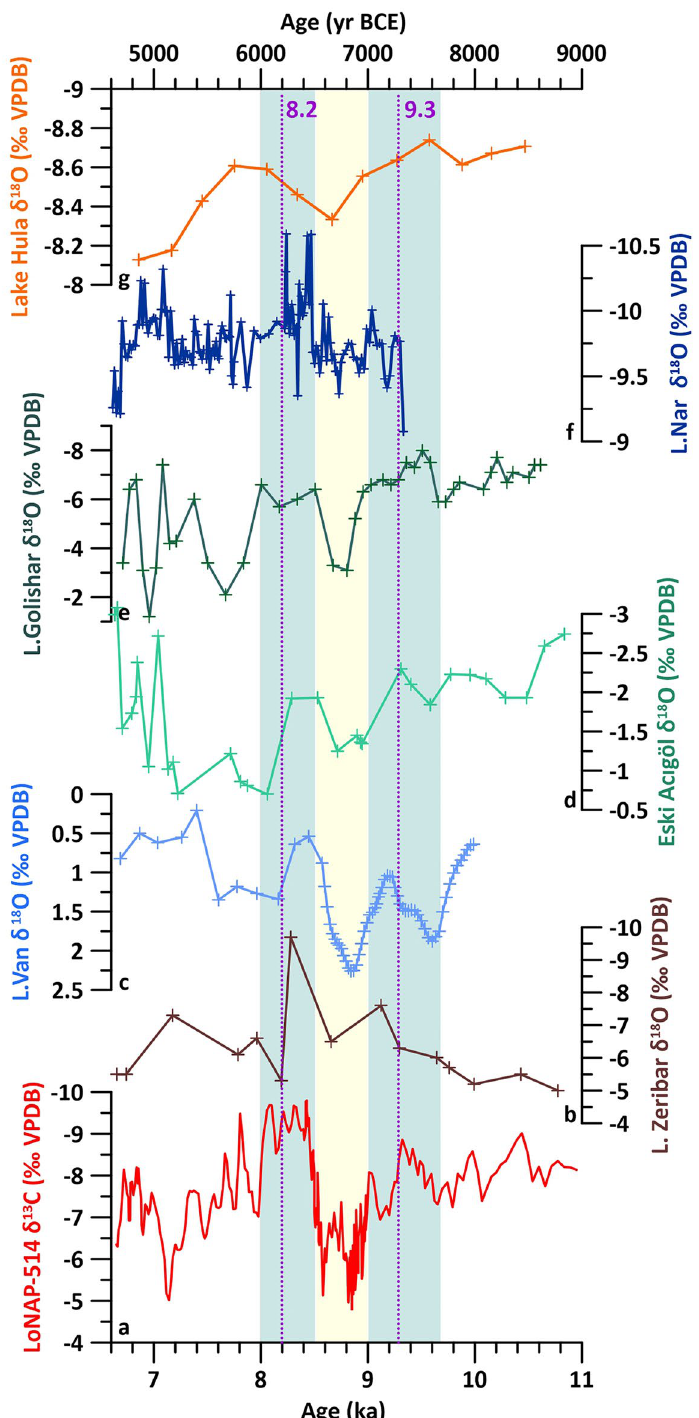
Figure 3. Regional comparison among ( a ) LoNAP514 δ 13 C (this study) and δ 18 O records from ( b ) Lake Zeribar 46 , ( c ) Lake Van 48 , ( d ) Lake Eski Acigöl 47 , ( e ) Lake Golishar 49 , ( f ) Nar Gölü 50 , ( g ) Lake Hula 45 . Blue/yellow shaded areas highlight the common main wetter/drier intervals; dotted lines indicate the 9.3 and 8.2 ka